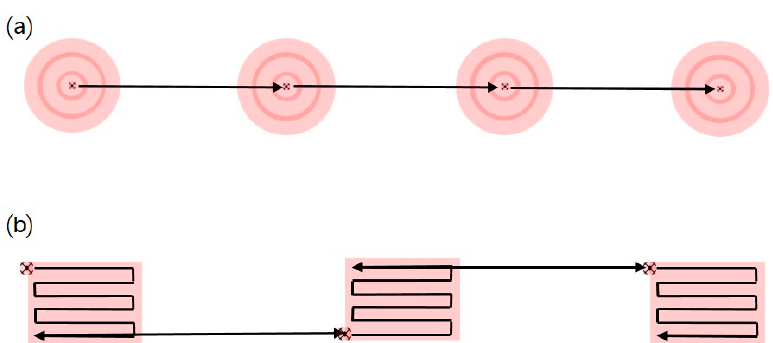
Figure 7. Examples of belt transect method using UAVs: ( a ) combining the point count survey and the line transect, ( b ) combining the plot sampling method and the line transect.